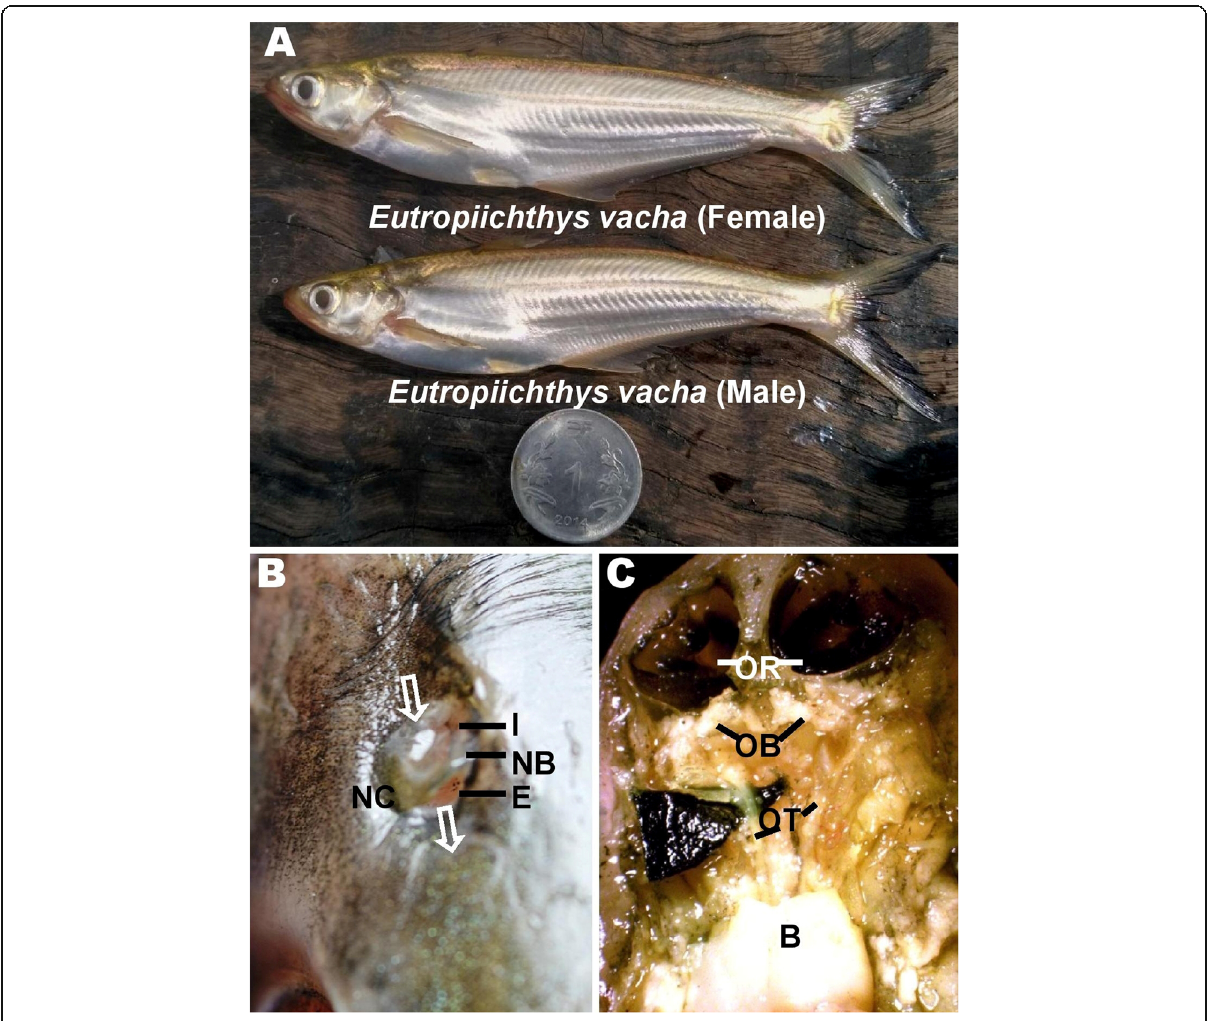
Fig. 1 Photographs showing the anatomical structure of olfactory apparatus in Eutropiichthys vacha . A Female and male E. vacha . B Nasal cavity (NC) exhibits incurrent (I) and excurrent (E) nares distinguished by nasal bridge (NB). Arrows mark pathway of water flow. C Dissected dorsal view of the brain (B) along with olfactory tracts (OT), olfactory bulbs (OB), and olfactory rosettes